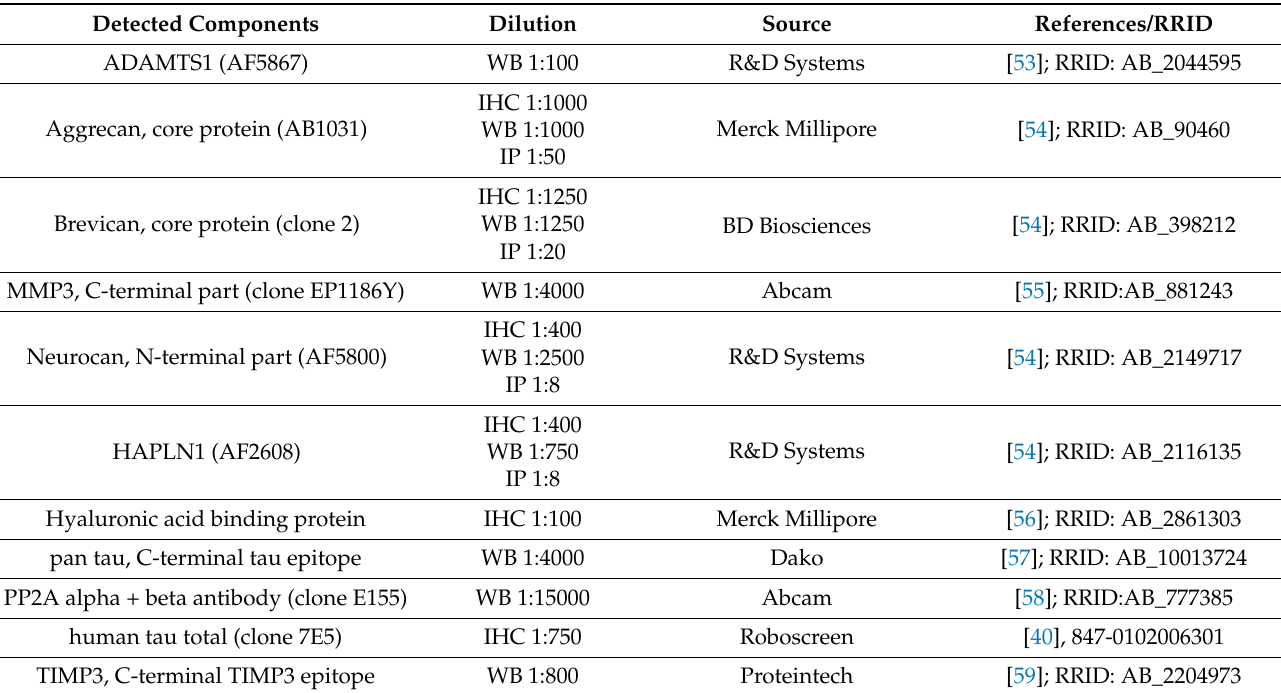
Table 1. Antibodies used for detection of perineuronal net components, enzymes and tau protein forms. Immunohistochemistry—IHC; Western blot—WB; Immunoprecipitation—IP. Detected Components Dilution